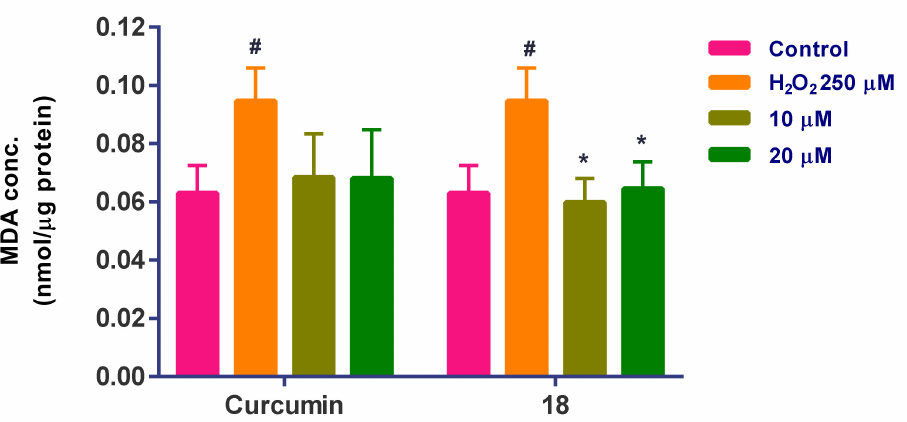
Figure 22. Effect of compound 18 and curcumin on MDA levels in SH-SY5Y cells exposed for 24 h to oxidative stress pressure with 250 µ M H 2 O 2 . Cells were treated with derivative 18 or curcumin at 10 and 20 µ M for 24 h prior to exposure to H 2 O 2 . Data are presented as the Mean ± SD of four independent experiments carried out in triplicate. # p < 0.001 vs. vehicle-treated control. * p < 0.05 vs. cells treated only with H 2 O 2